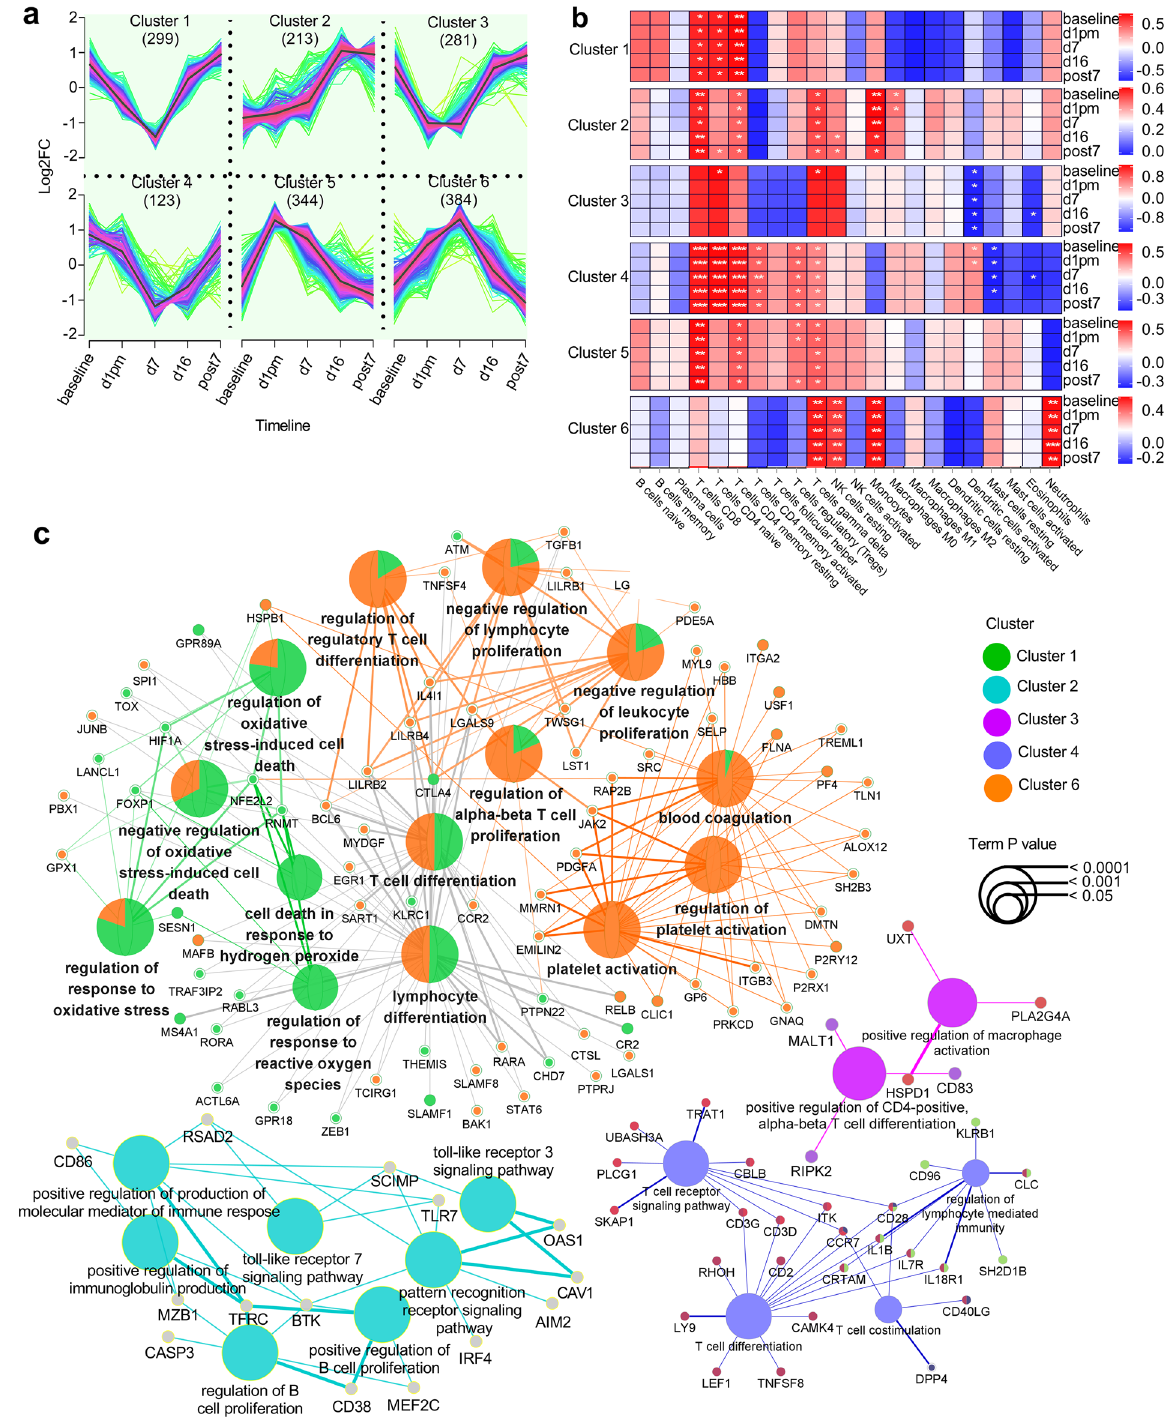
Figure 2. The genetic and immune functional responses to VLH exposure. ( a ) Timeline genetic responses of 1644 DGs in the six clusters. Gene expression changes were normalized using log2. ( b ) Dynamic leukocyte functional differentiation in each cluster. Backgrounded by LM22, each cluster was significantly annotated with genetic associations to different leukocyte types (two-tailed spearman correlation test, N = 22, * P < 0.05, ** P < 0.01, *** P < 0.001). ( c ) Functional enrichment analysis based on the GO databases. A built-in ClueGOPlugin (v.2.5.9) in the software Cytoscape (3.9.1) was applied in the GO